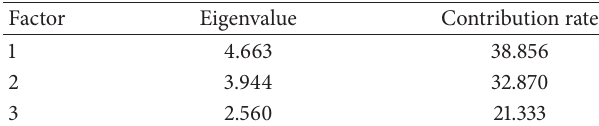
Table 3: Contribution rate.